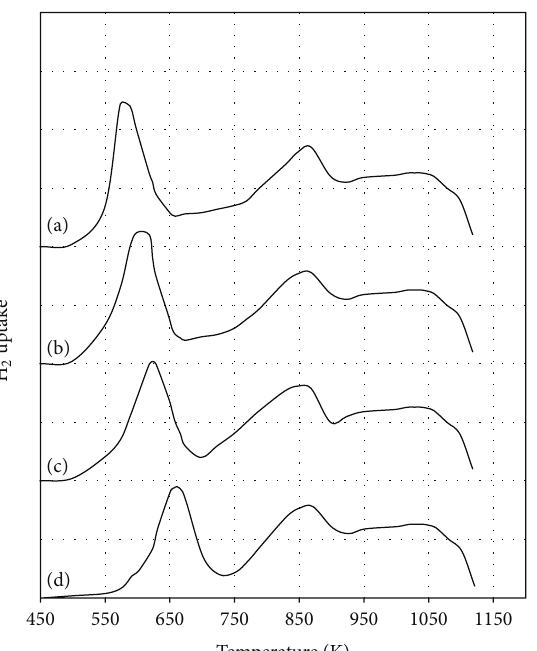
Figure 6: TPR profiles of prepared catalysts after calcinations ((a) HLB = 13.9, (b) HLB = 23.7, (c) HLB = 31.2, and (d) HLB = 40).